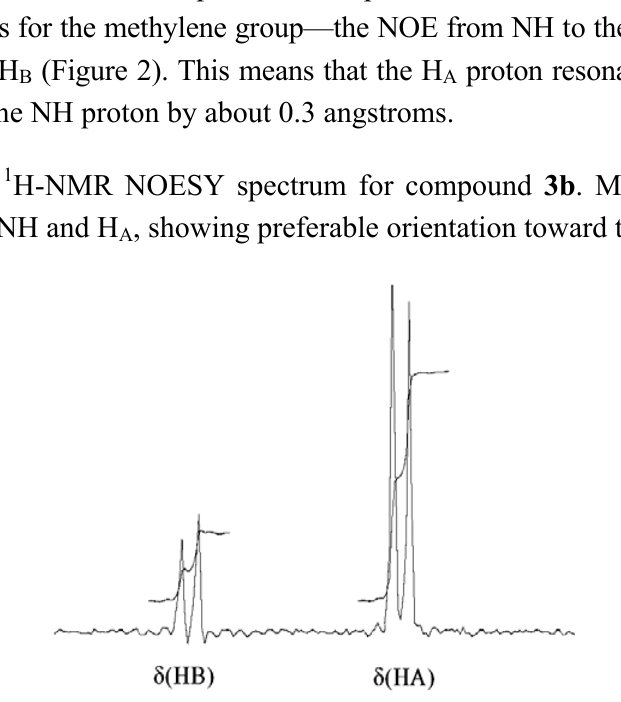
Figure 3. 1 Н -NMR spectral data of D